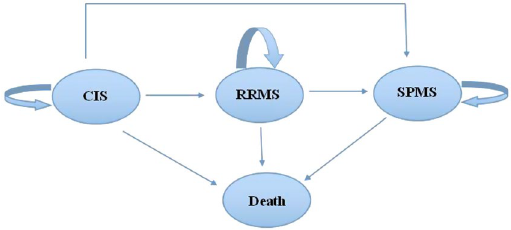
Figure 1. The possible transitions from CIS during disease progression. CIS: clinically isolated syndrome; RRMS: relapsing-remitting multiple sclerosis; SPMS: secondary progressive multiple sclerosis.